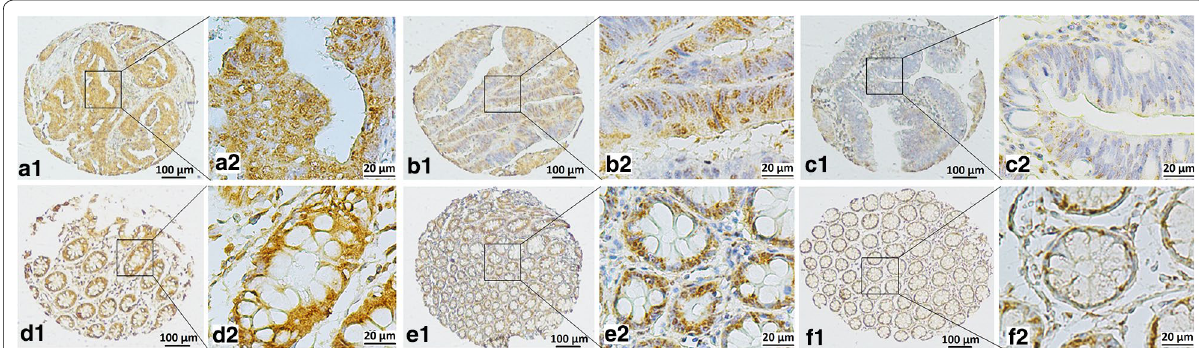
Fig. 3 Representative TMA-IHC figures of estrogen receptor-β (ER-β) expression. a1 , a2 high ER-β expression in colon adenocarcinoma with strong intensity and 80% malignant cells staining in nucleus; b1 , b2 moderate ER-β expression in colon adenocarcinoma with strong intensity and 45% malignant cells staining in nucleus; c1 , c2 low ER-β expression in colon adenocarcinoma with moderate intensity and 30% malignant cells staining in nucleus; d1 , d2 high ER-β expression in tumor-adjacent normal tissue with strong intensity and 95% epithelial cells staining in nucleus; e1 , e2 moderate ER-β expression in tumor-adjacent normal tissue with strong intensity and 60% epithelial cells staining in nucleus; f1 , f2 low ER-β expres- sion in tumor-adjacent normal tissue with strong intensity and 30% epithelial cells staining in nucleus